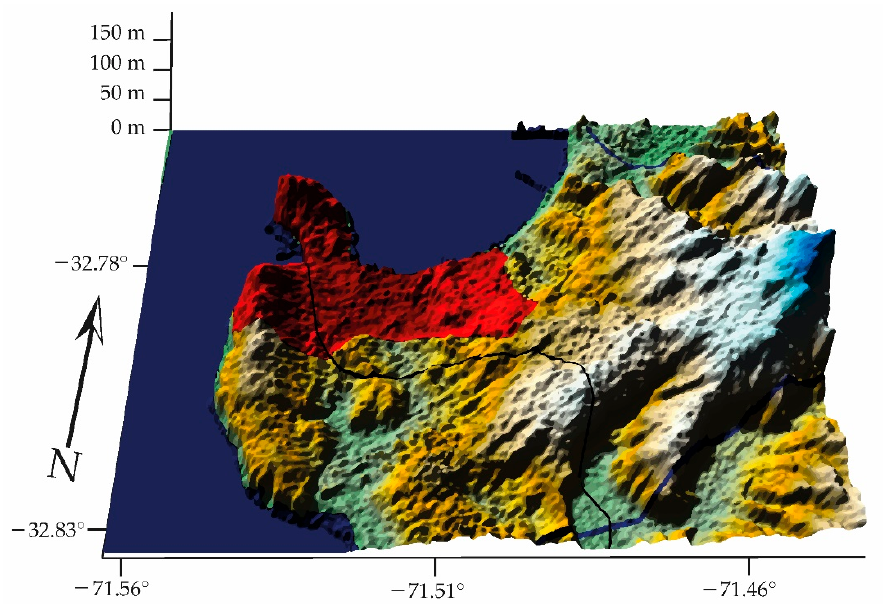
Figure 19. C K, Loncura = 1.66 , micrometeorological activity dominates that of pollutants (GCS, WGS84). (m) The Lota Rural station is located in the district of Coronel (Figure 20):